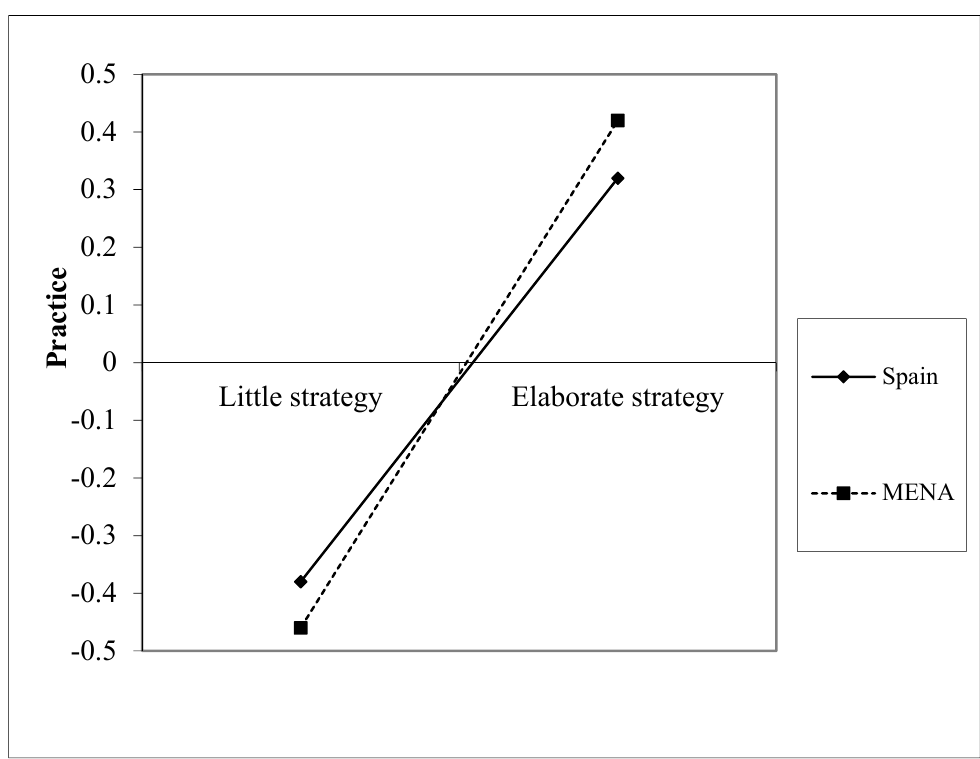
Figure 5. Practice affected by strategy, in MENA and in Spain.